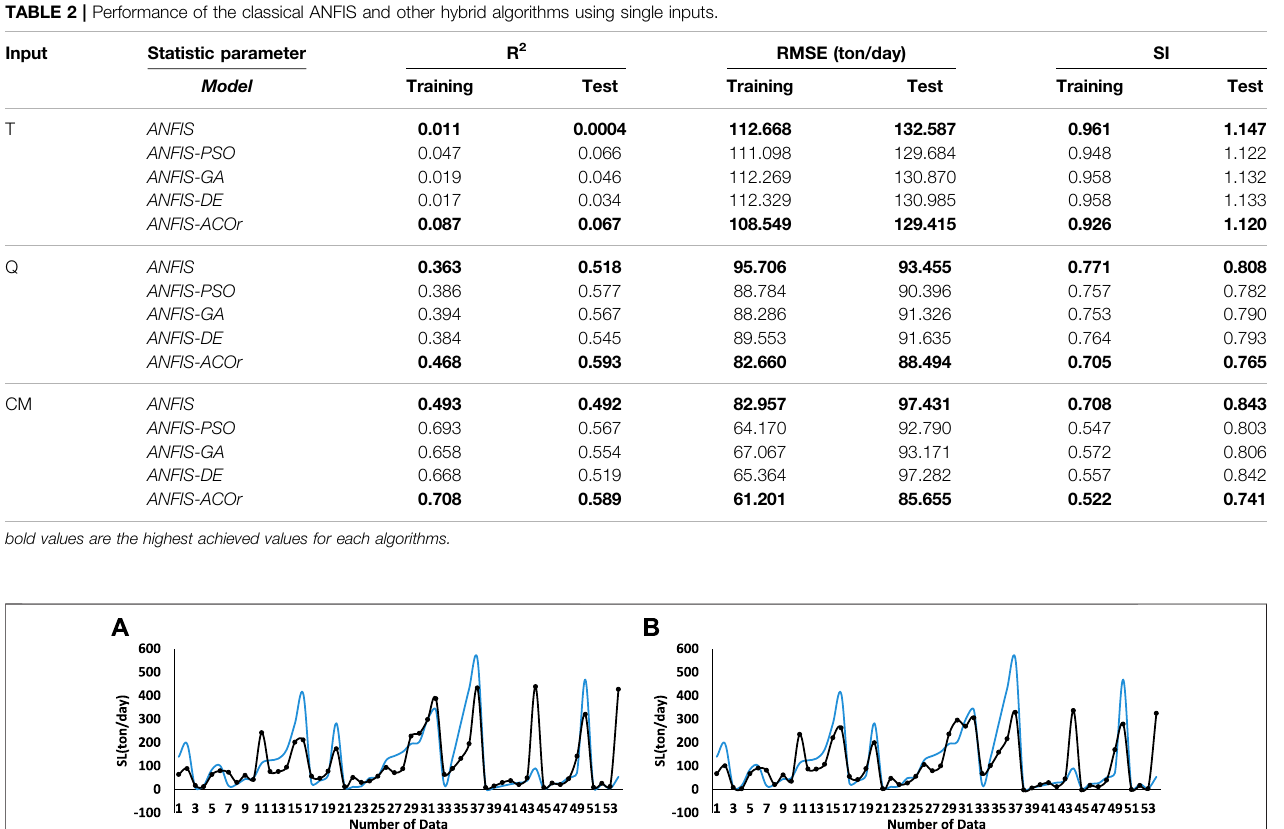
TABLE 2 | Performance of the classical ANFIS and other hybrid algorithms using single inputs.